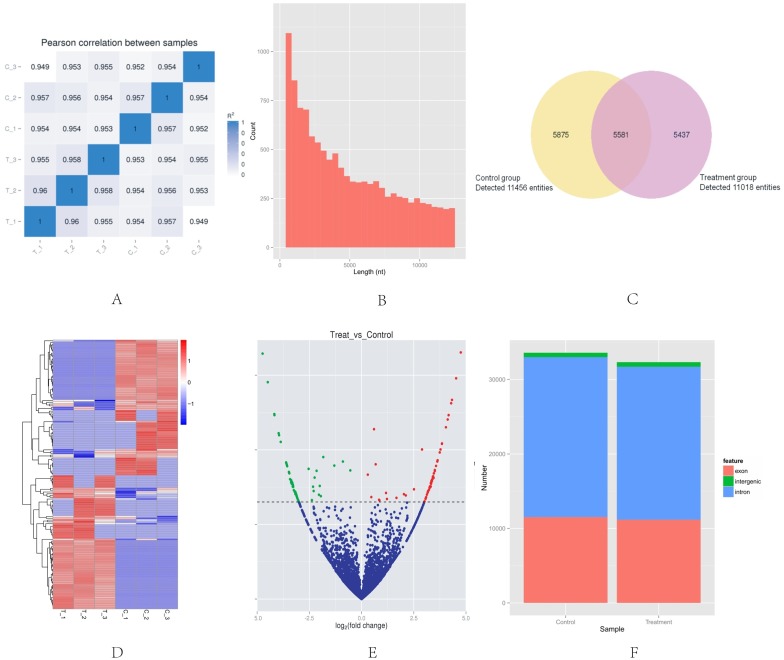
Basic situation of high-throughput sequencing.(A) Inter–sample expression correlation test. Two groups of HeLa cells were used and each group contained three samples. The cell groups were treated by different methods. The correlation between gene expression levels in different samples indicated the biological repetition. The greater the absolute value of r indicates that the stronger the correlation. (B) CircRNA length distribution. Approximately 67% of circRNAs had the predicted spliced length of <10,000 nt, whereas 46.4% and 32.0% of the circRNAs had a length of <5,000 and 10,000–50,000 nt, respectively. (C) Venn diagram of the differential expression of circRNAs. The yellow part of the circle is the Control group and the purple part of the circle is the Treatment group. The total number of the circRNAs was 16,893. Approximately 11,456 circRNAs were detected in the control group, 11,018 in the treatment group, and 5,581 in both groups. (D) Hclusterheatmap. Hierarchical clustering showing the differential expression profile of circRNAs between the two study groups and the homogeneity within each group. (E) Volcano plot of differentially expressed circRNAs. The green and red dots in the plot represent the differentially expressed circRNAs with statistical significance. The red dots correspond to upregulated circRNAs and the green dots correspond to downregulated circRNAs. (F) circRNA genomic feature data. It shows the novel genomic feature of circRNAs in both groups. The red part is exon, green part is intergenic, and blue part is intron.